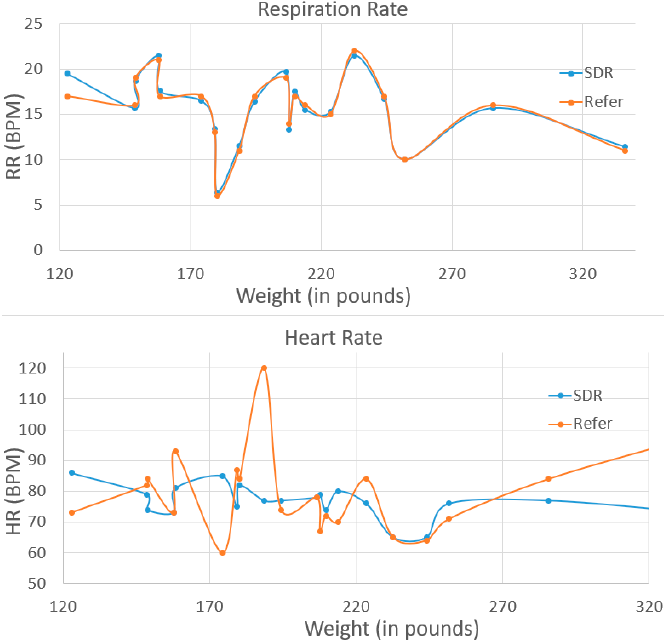
Figure 10. Clinical trial test data on 20 cases sorted by weight.